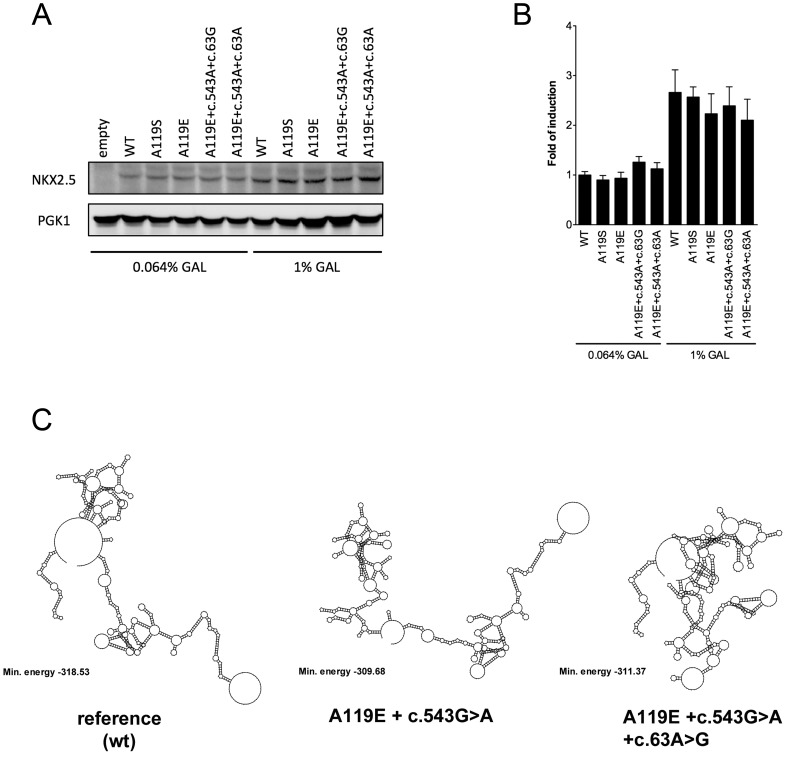
Western blotting at different expression levels and predictions of NKX2-5 RNA folding.(A) Yeast strain yLFM_ECE-2 harboring plasmid borne NKX2-5 alleles as indicated were grown to exponential phase at 0.064% as well 1% galactose and harvested after 24 hours. 100 µg of whole cell extract was subjected to gel electrophoresis through a 7.5% SDS polyacrylamide gel, transferred to a nitrocellulose membrane, and subjected to immunoblotting using antibodies against the ectopic transactivation domain present at the N-terminus of all the NKX2-5 proteins and against PGK1 used as reference. (B) Densitometric analysis of two independent Western blots experiments. Results are presented relative to the abundance of wt NKX2-5 measured from extracts obtained with yeast cells grown at 0.064% galactose. PGK1 was used as reference. The error bars represent the range of variation of the two independent experiments. (C) Predictions on mRNA secondary structure, as determined by the Vienna RNA folding procedure, showing differences in folding and minimum free energy between reference (wild type) and in the combination of variant alleles. The predicted minimum free energy values for the combined variants suggest less stable structures as compared to the reference. The 975-bp coding sequence of NKX2-5 was used for the prediction.